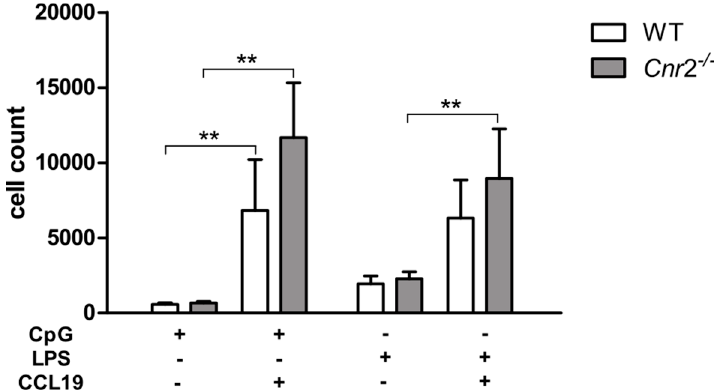
Figure 3. In vitro migration of activated BM-DCs towards CCL19 is not affected by CB2 deficiency. Migratory behavior of BM-DCs from WT ( n = 5) and Cnr2 − / − ( n = 5) mice in transwell migration assays in response to 200 ng/mL CCL19 or medium only. CpG or LPS activated WT or Cnr2 − / − BM-DCs were seeded in the upper transwell chambers. After 4 h cells were collected in the bottom well and cell counts determined. Data show mean values ± SD ( n = 4–5 animals/group). ** p < 0.01.